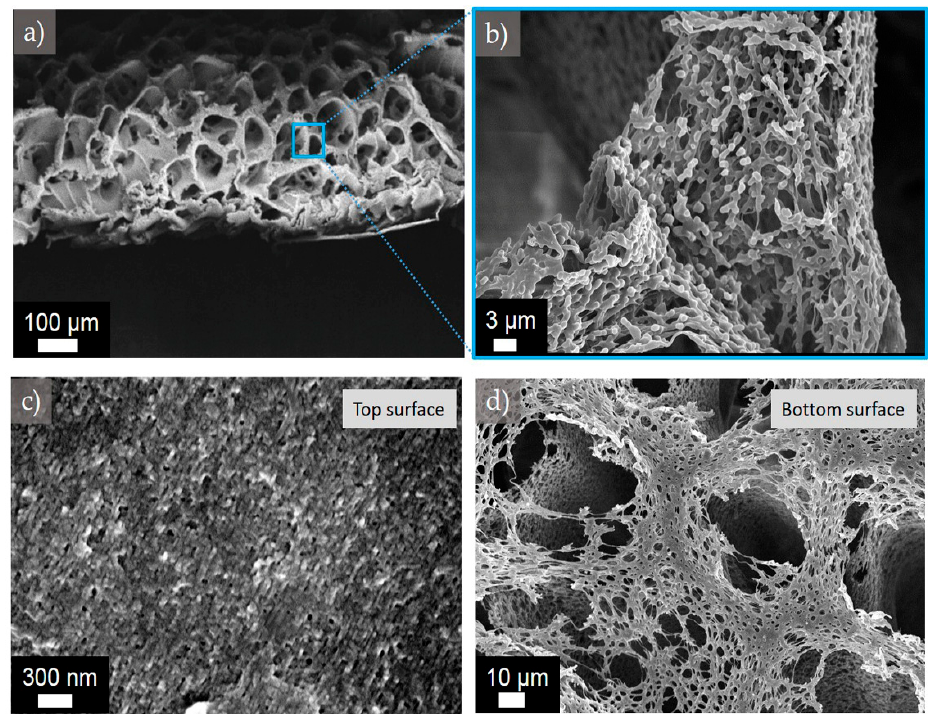
Figure 8. Representative SEM images obtained for the membrane M2-20: ( a ) and ( b ) cross-section at two different magnifications; ( c ) top and ( d ) bottom surface structure. Table 7. Preparation of membranes with 80/20 w / w or 70/30 w / w PDSPP/SPDSPP in NMP at 10%, addition of PVP at 3.3% w / w final concentration, casting at 80 ◦ C until 20% w / w total final polymers’